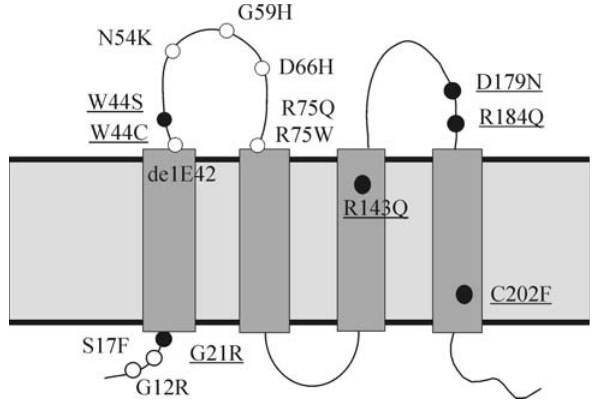
Figure 2 - Dominant mutations in the connexin 26 protein. Non-syndro- mic mutations are underlined and are represented by dark circles while syndromic mutations are represented by white